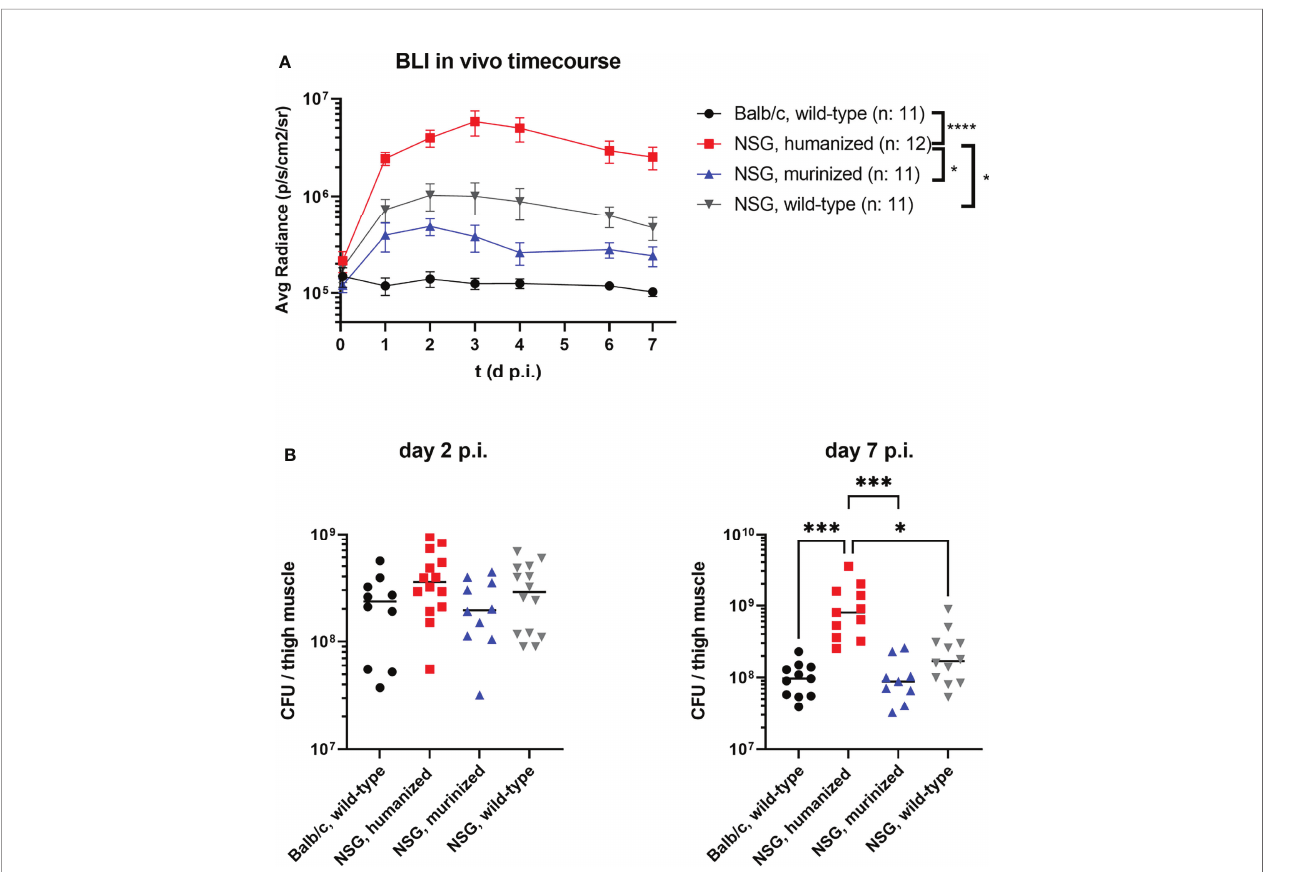
FIGURE 1 | The course of MRSA thigh muscle infection in humanized and control mouse groups. Mice were infected with 1x10 8 CFU S. aureus LAC* lux into the left thigh muscle. (A) Bioluminescence signal of the luciferase-expressing bacteria at the primary site of infection (thigh muscle) was measured every 24 hours. Depicted are the mean radiance levels +/- SEM for each respective group. Statistical signi fi cance was tested for each time point with Kruskal-Wallis test. (B) The infected thigh muscles were recovered at either day 2 or day 7 p.i., homogenized and plated in serial dilutions on agar plates to determine the bacterial burden. Shown are the individual colony-forming-units (CFU) per mouse and the corresponding medians per group. Statistical signi fi cance was determined by Kruskal-Wallis with Dunn ’ s post-test (*p ≤ 0.05, ***p ≤ 0.001, ****p ≤